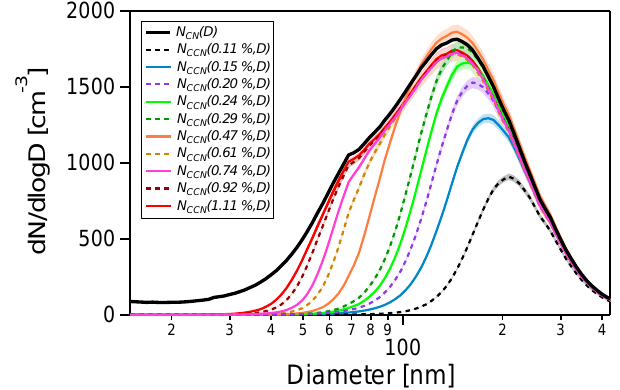
Figure 4. Number size distributions of total aerosol particles, N CN ( D ), and of cloud condensation nuclei, N CCN ( S,D ), at all 10 supersaturation levels ( S = 0.11–1.10%) averaged over the entire measurement period. The N CCN ( S,D ) size distributions were cal- culated by multiplying the average N CN ( D ) size distributions (in Fig. 3) with the average CCN activation curves in (Fig.